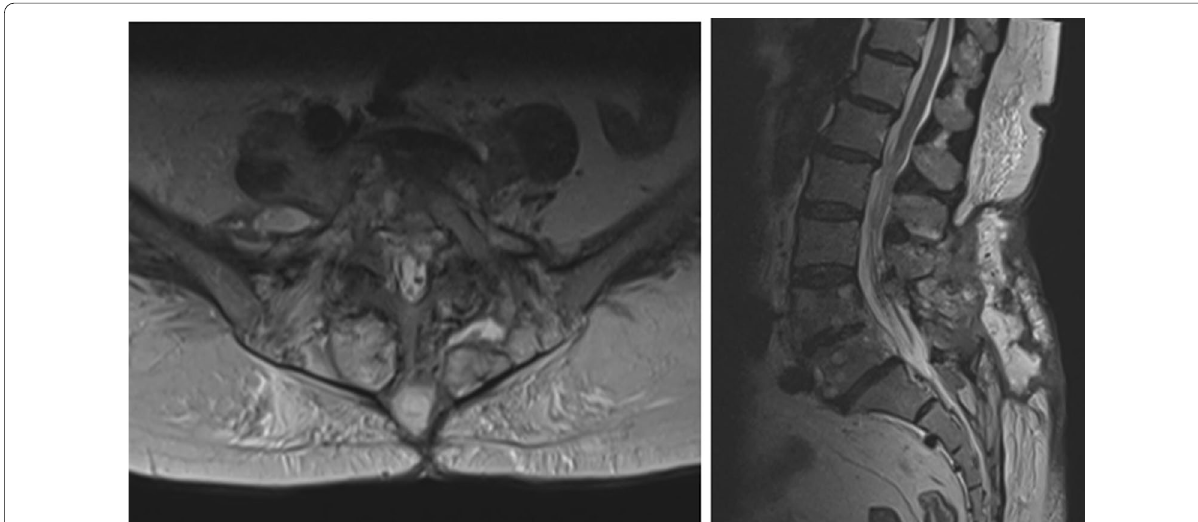
Fig. 5 Postoperative lumbo-sacral spinal MRI—axial and sagittal